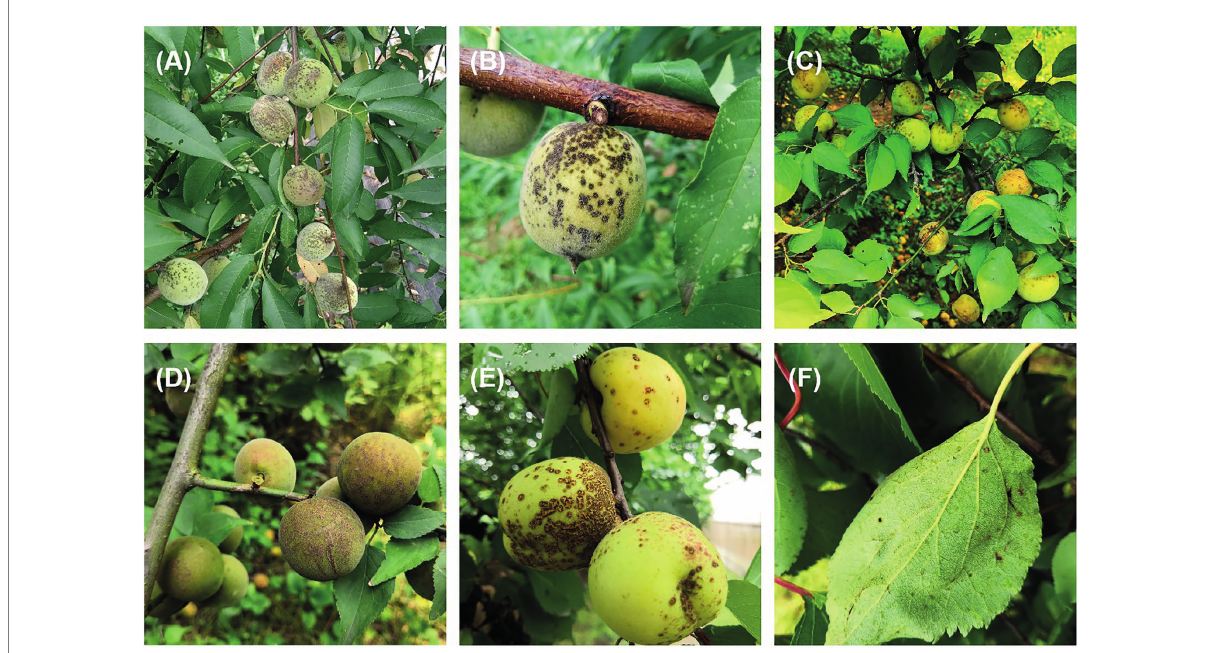
FIGURE 1 Typical symptoms of scab on peach, mume, and apricot. (A,B) Typical symptoms on peach, (C,D) on mume, (E,F) on apricot fruit and leaf,